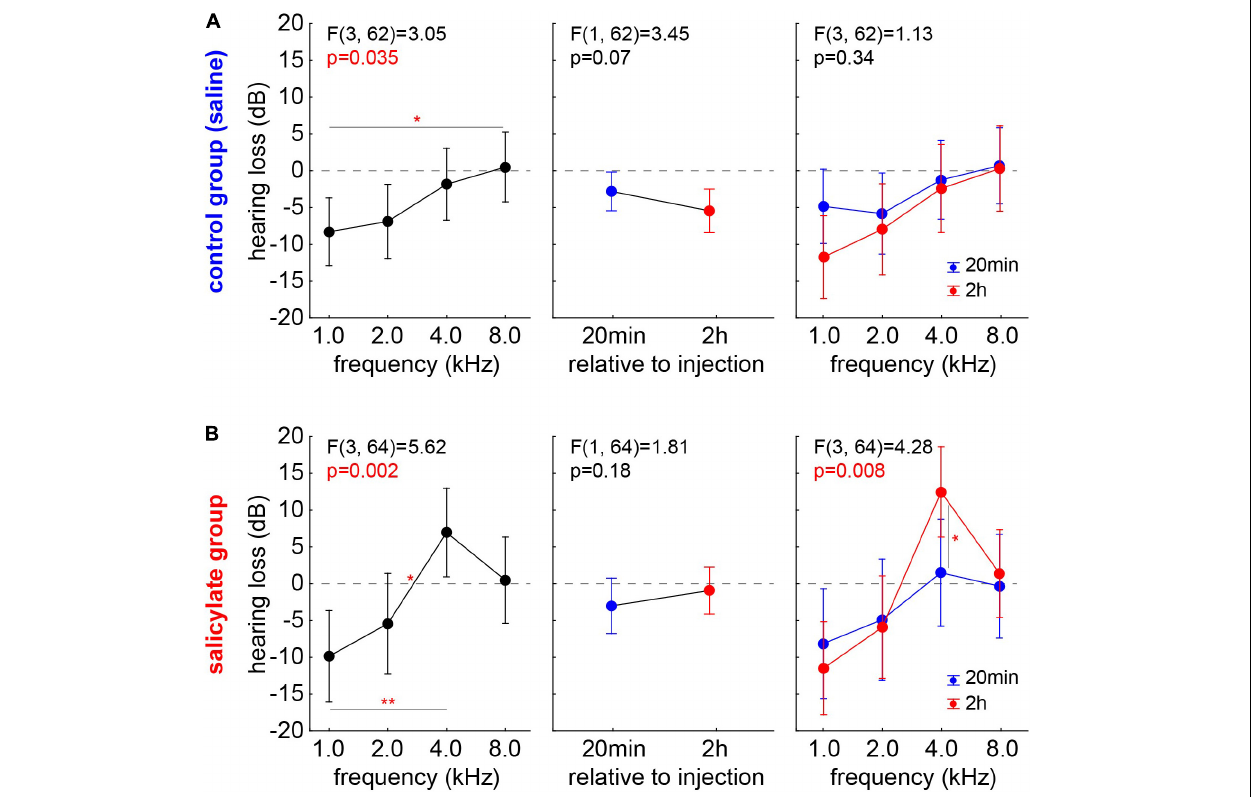
FIGURE 4 | HL in control and salicylate animals analyzed with one factorial repeated measurement mixed ANOVAs with factor frequency (left panels), repetition factor time (20 min and 2 h; center panels) and the interaction of both factors (right panels). (A) In group C, mostly negative HL values could be found over all frequencies with significant frequency dependency but no significant difference between the average HL of 20 min and 2 h or in the interaction of the factors could be found. (B) In group S, significant frequency dependency of the HL was found, no significant HL difference between the two time points but a significant interaction of time X frequency with a significant Tukey post hoc test at 4 kHz emerged. * p < 0.05; ** p <